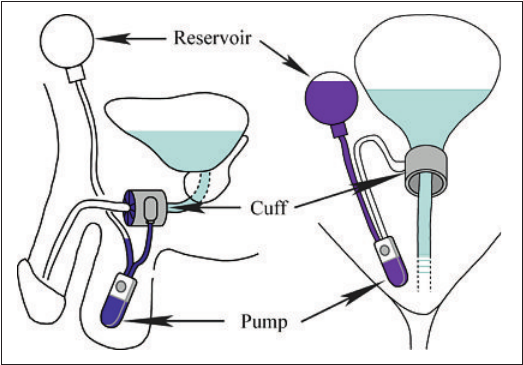
The AMS 800™, re- garded as the gold standard for the treatment of severe urinary incontinence, consists of pump, cuff, and reservoir. The fluid-filled cuff generates a constant pressure on the ure- thral tissue, set by the surgeon.The male or female pa- tient can pass water by manually operat- ing the pump in the scrotum and labium respectively.The pump transports the fluid from the cuff to the reservoir, whereby the urethra opens.